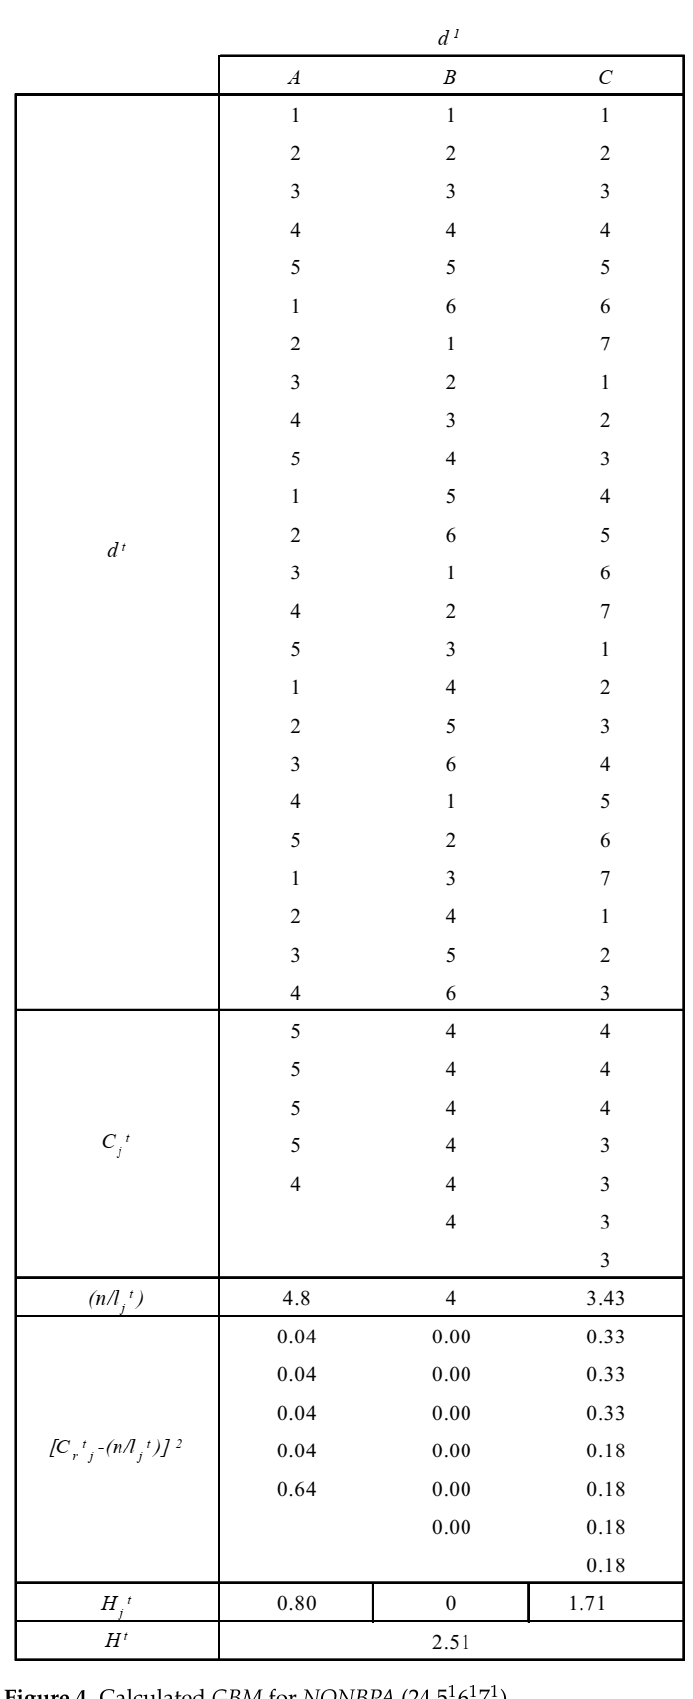
Figure 4. Calculated GBM for NONBPA (24,5 1 6 1 7 1